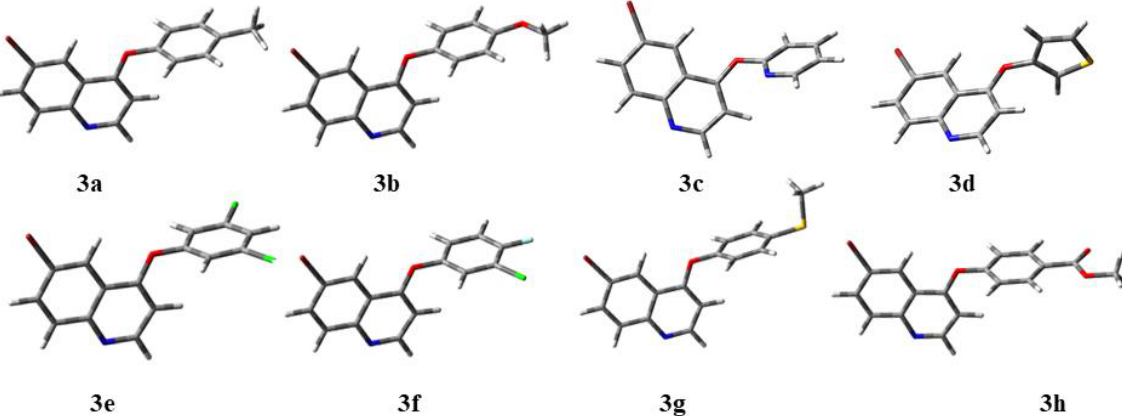
Figure 6. Optimized geometry of compounds 3a – 3h . In 3D representations, the elements of carbon, hydrogen, oxygen, chlorine, fluorine, bromine, sulfur, and nitrogen are symbolized by gray, white, red, green, sky blue, brown, yellow, and blue color, respectively. Table 6. Experimental and theoretical calculated 1 H-NMR of compound 3a . Carbon